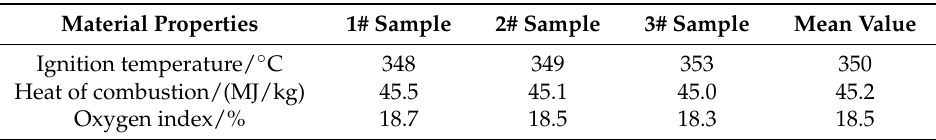
Table 1. Material properties of XPS panel. Table 1 . Material properties of XPS panel.